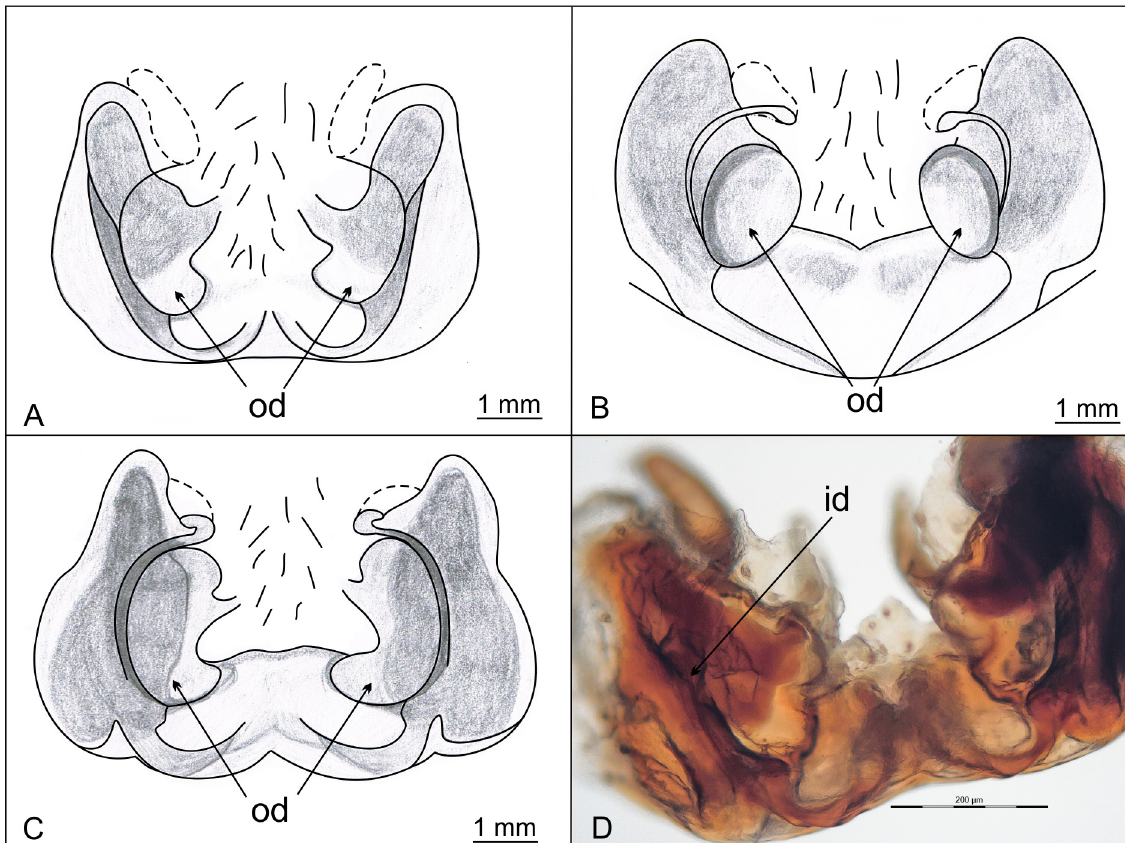
Fig 4. Epigyne and vulva. A . Kryptonesticus deelemanae gen. et sp. nov., epigyne. B . K. fagei (Kratochvíl, 1933), epigyne. C . K. arenstorffi (Kulczyński, 1914), epigyne. D . K. deelemanae gen. et sp. nov. vulva. Broken lines mark the positions of the